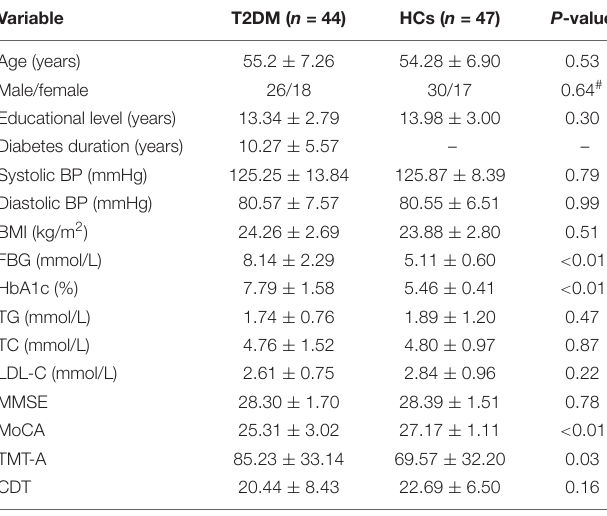
TABLE 1 | Demographic, clinical, and cognitive data of the patients with T2DM and the HCs.